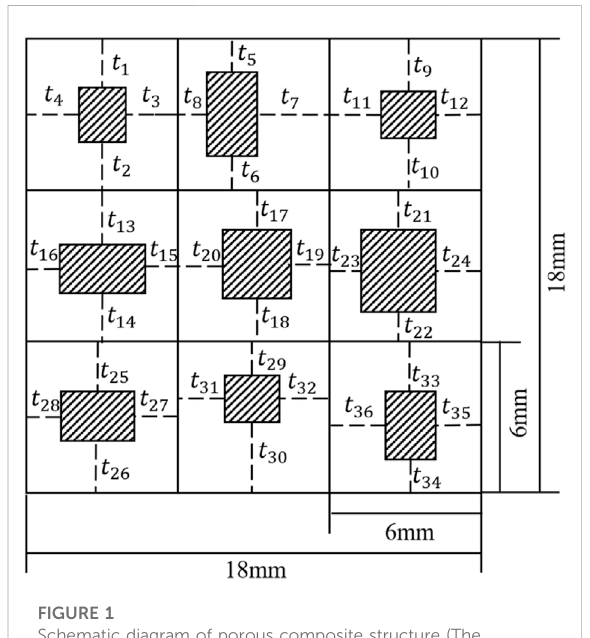
FIGURE 1 Schematic diagram of porous composite structure (The shaded areas are the pores).